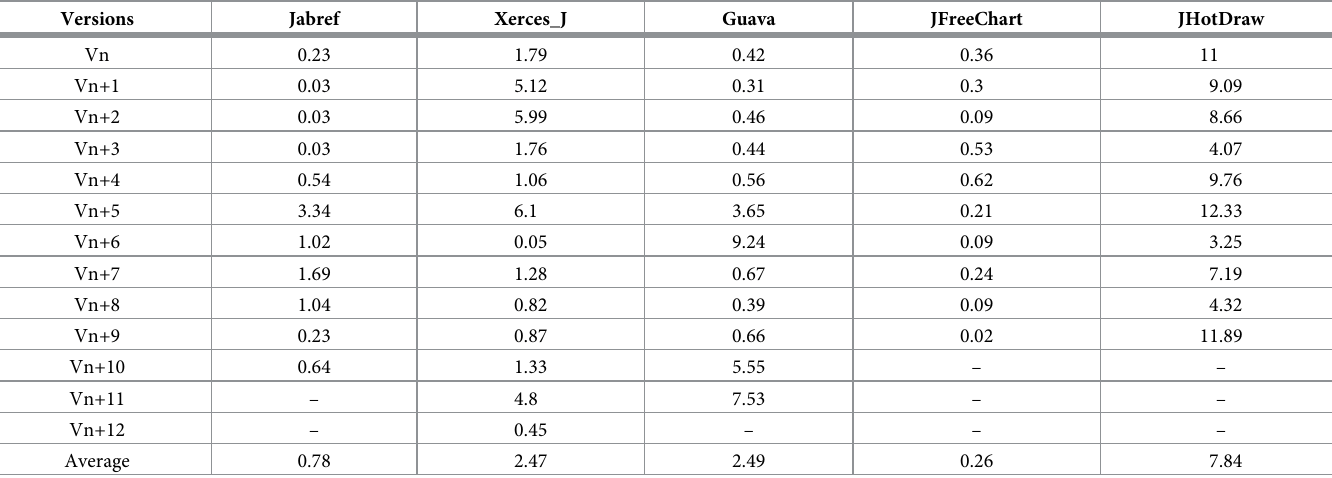
Table 3. Percentage of clone refactoring ratio in versions of five Java